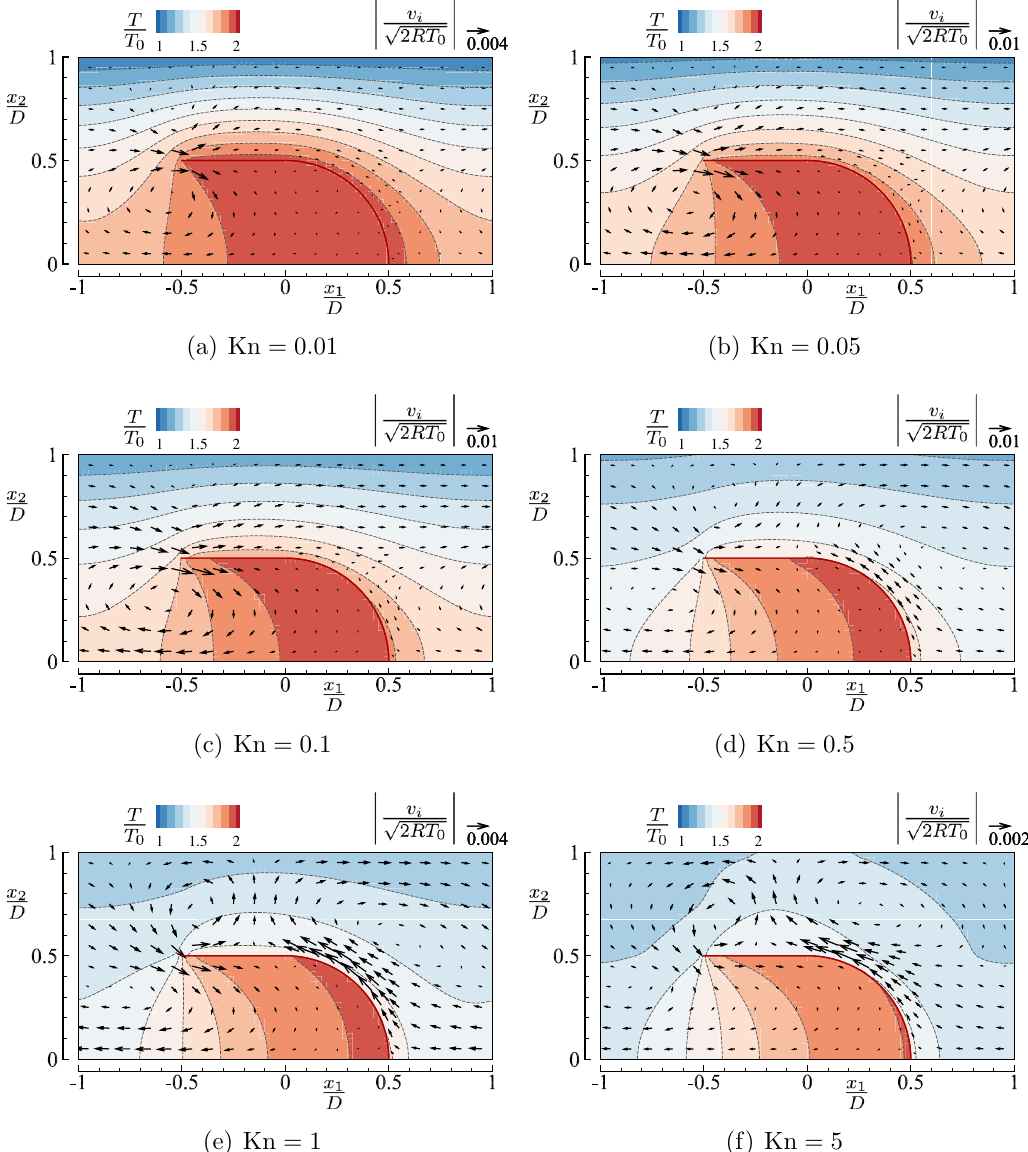
Figure 8. Flow velocity vector ( v 1 , v 2 ) and contour map T in the case of an array of round-U bodies 2 , H / D 2 , and L / D 1 ) for typical Knudsen numbers Kn ( T 1 / T 0 = = = and ( f ) 5. See the caption of Fig.